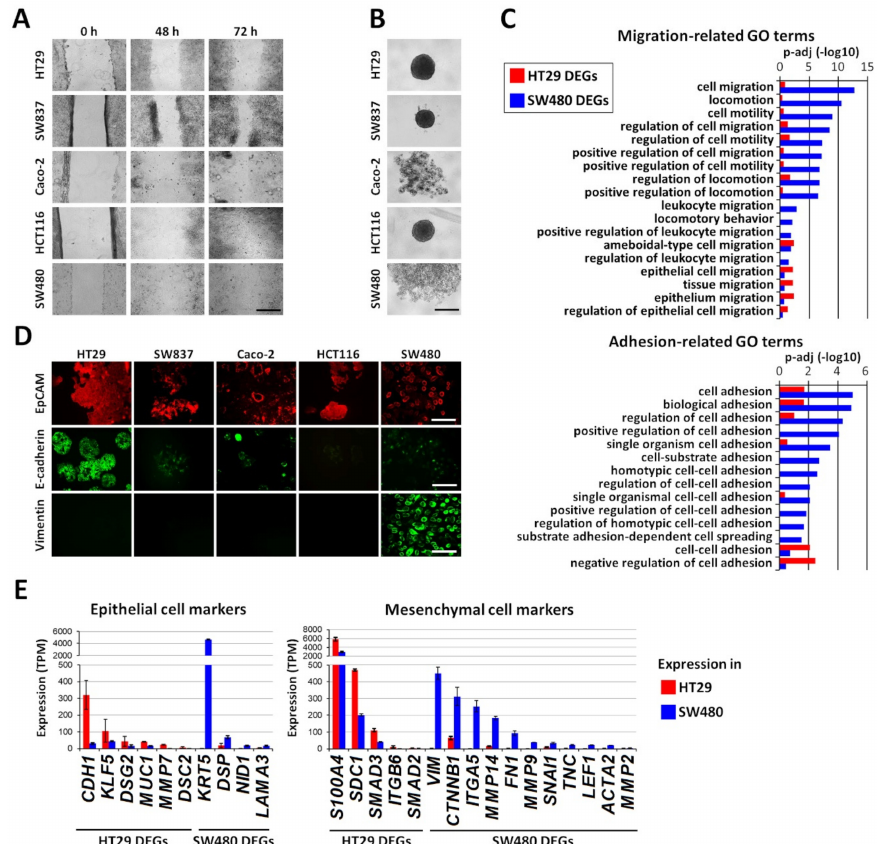
Figure 1. Identification of epithelial / mesenchymal state of five human colorectal cancer cell lines. ( A ) Monitoring of cell migration using wound-healing assay. Representative microscopic images of wound closure at 0, 48, or 72 h post wounding. Scale bar, 400 µ m. ( B ) Spheroid formation ability of colorectal cancer cell lines. Cell lines were cultured on ultra-low attachment round-bottom plates, and the optical microscopy images were obtained 7 days after cell seeding. Scale bar, 400 µ m. ( C ) Cell migration- and adhesion-related Gene Ontology Biological Process (GO BP) terms that are enriched in sets of di ff erentially expressed genes between the HT29 and SW480 cancer cell lines. RNA-seq data were used to identify di ff erentially expressed genes ( | log2(FC) | > 1) that were subjected to functional enrichment analyses using the DAVID analysis tool to identify enriched GO BP terms. ( D ) Immunofluorescence staining of the indicated cell lines for the epithelial cell adhesion molecule (EpCAM) (red) and the epithelial marker E-cadherin (green) and mesenchymal markers vimentin (green). Representative fluorescence microscopic images showing the epithelial phenotype of HT29 cells and the mesenchymal phenotype of SW480 cells. Scale bar, 400 µ m. ( E ) Expression of epithelial and mesenchymal marker genes di ff erentially expressed between HT29 and SW480 cancer cells. RNA-seq data were used to calculate the gene expression levels in transcripts per kilobase million (TPM). Mean values ± standard deviation in triplicate are